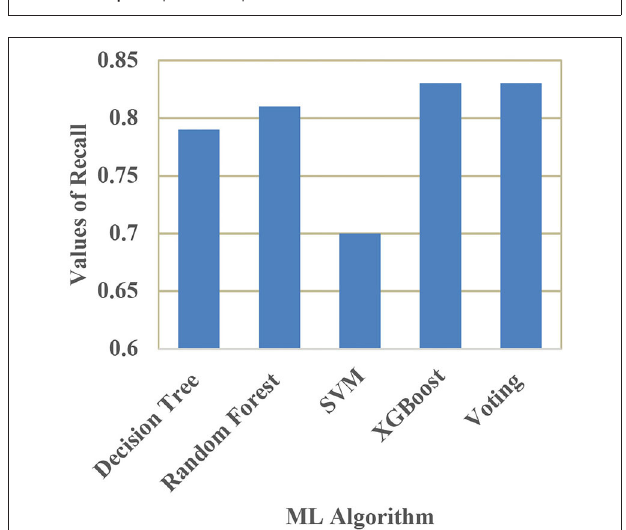
FIGURE 16 | Comparison of recall.